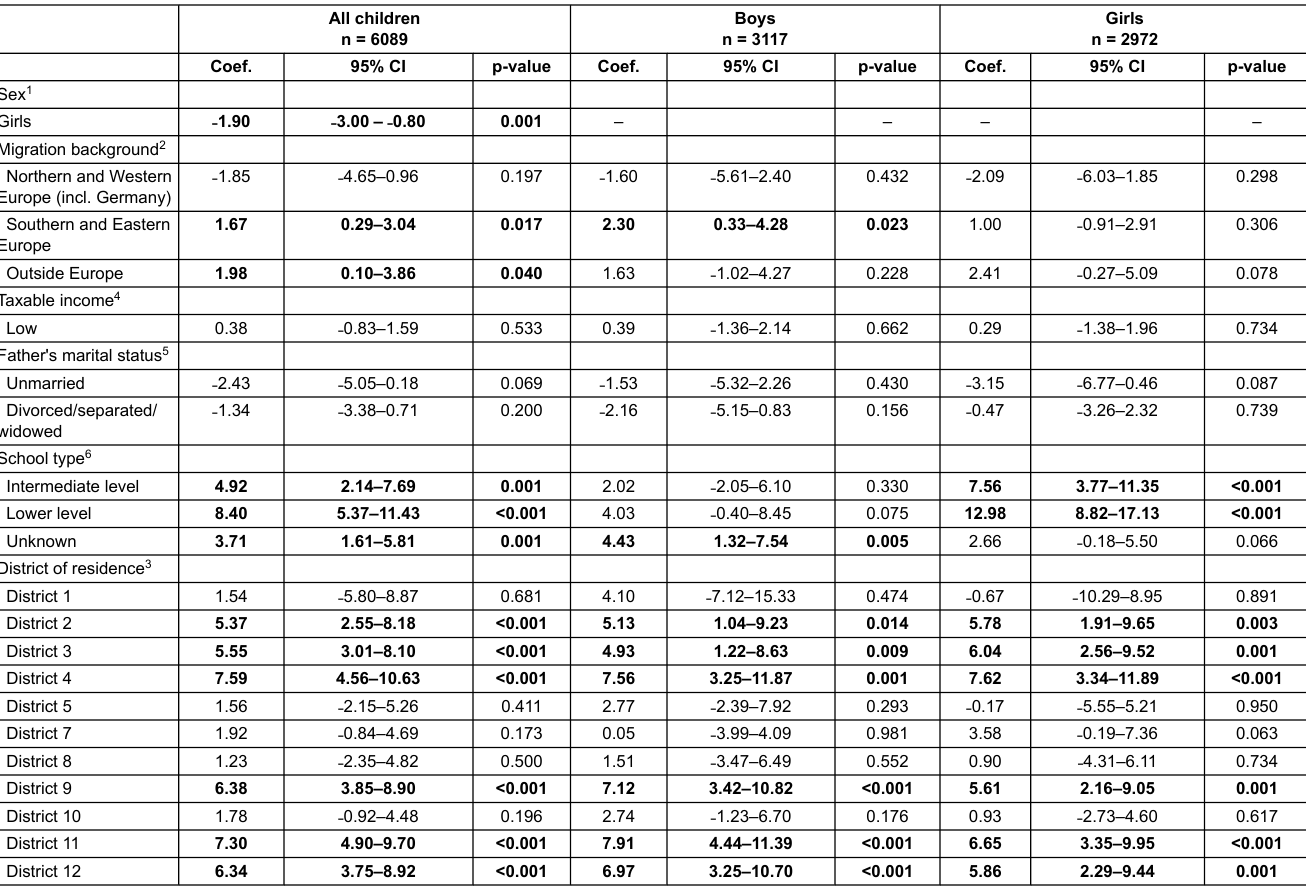
Table 4: Results of a linear regression model for differences in BMI percentile over school time, based on sociodemographic variables, total and by